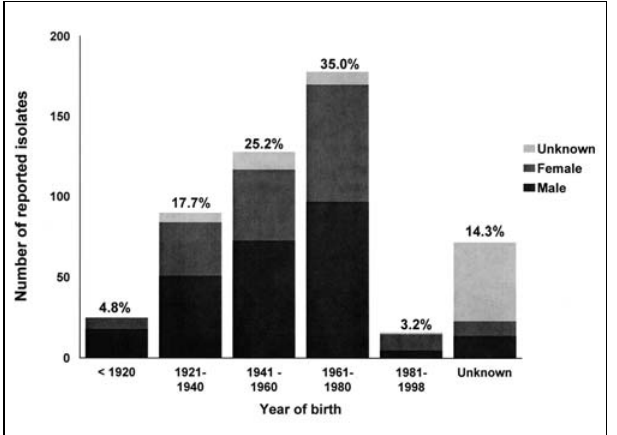
Tuberculosis (TB) drug resistance reporting in Canada by province and territory, 1998 to 2000 Alberta